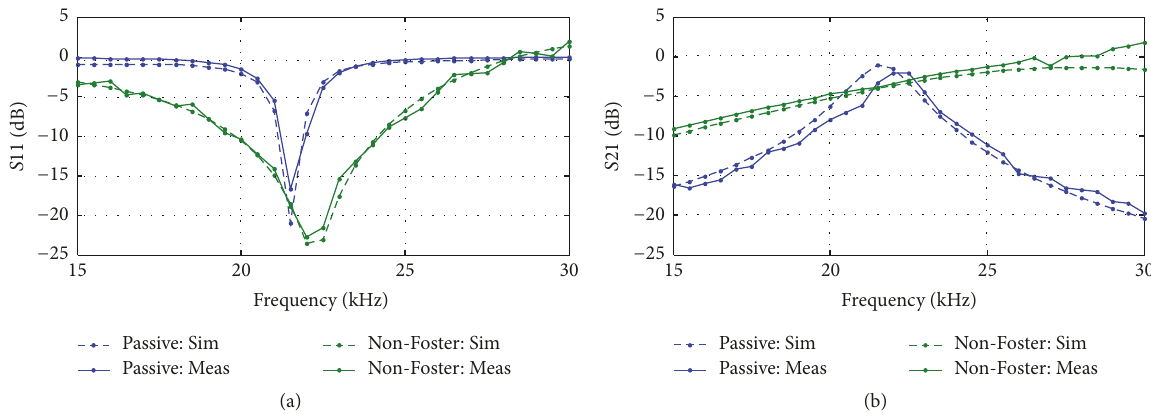
Figure 11: (a) Comparison of measured and simulated 𝑆 11 of NFC and passive matching network under condition of SW1–SW3 off and SW4 on. (b) Comparison of measured and simulated 𝑆 21 of the NFC and passive matching network under condition of SW1–SW3 off and SW4 on.